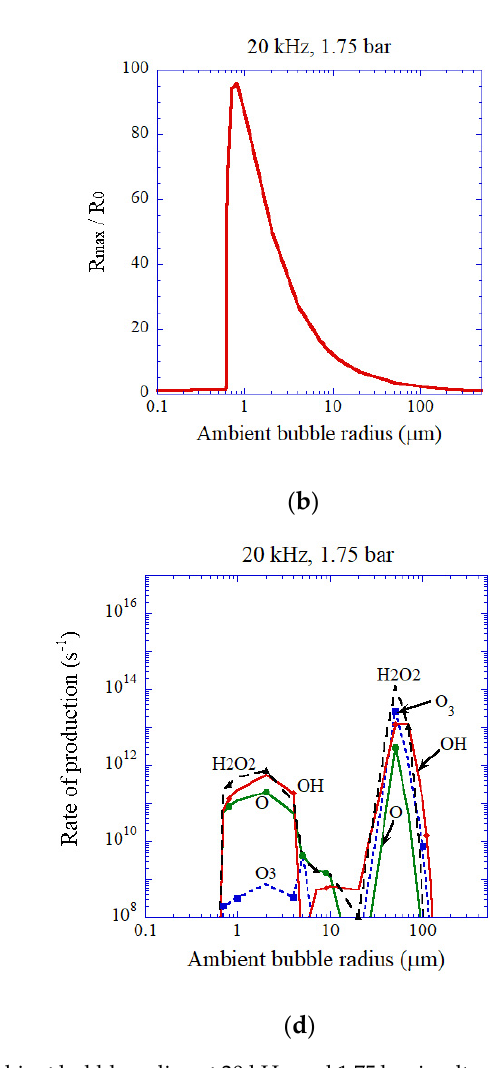
Figure 16. The calculated results for an air bubble as a function of ambient bubble radius at 20 kHz and 1.75 bar in ultrasonic frequency and acoustic amplitude, respectively [43]. The horizontal axis is in logarithmic scale. ( a ) The peak temperature (solid) and the molar fraction of water vapor (dash dotted) inside a bubble at the end of the bubble collapse. ( b ) The expansion ratio (R max /R 0 ). ( c ) The intensity of each emission process in SL. The vertical axis is in logarithmic scale. ( d ) The rate of production of each oxidant with the logarithmic vertical axis. Copyright 2008, with the permission of AIP Publishing.